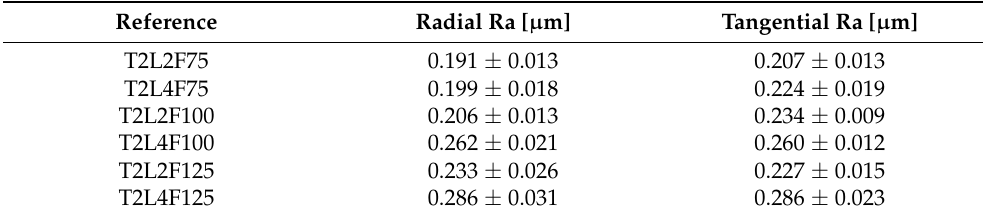
Table 6. Average surface roughness values, measured in the radial and tangential direction, for tests conducted using T2.